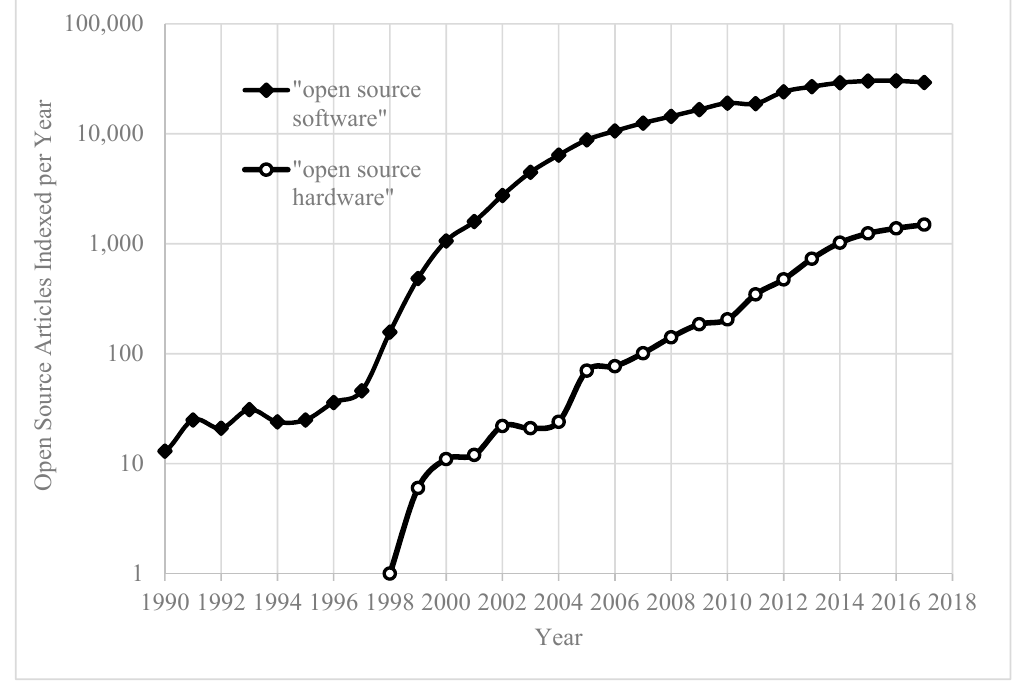
Figure 1. Articles indexed by Google Scholar containing the phrase “open source software” and “open source hardware” from 1990 until 2017 shown on a logarithmic scale because of the orders of magnitude changes.